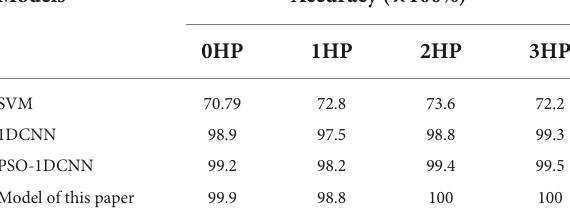
TABLE 3 Comparison of bearing fault diagnosis results between different models.